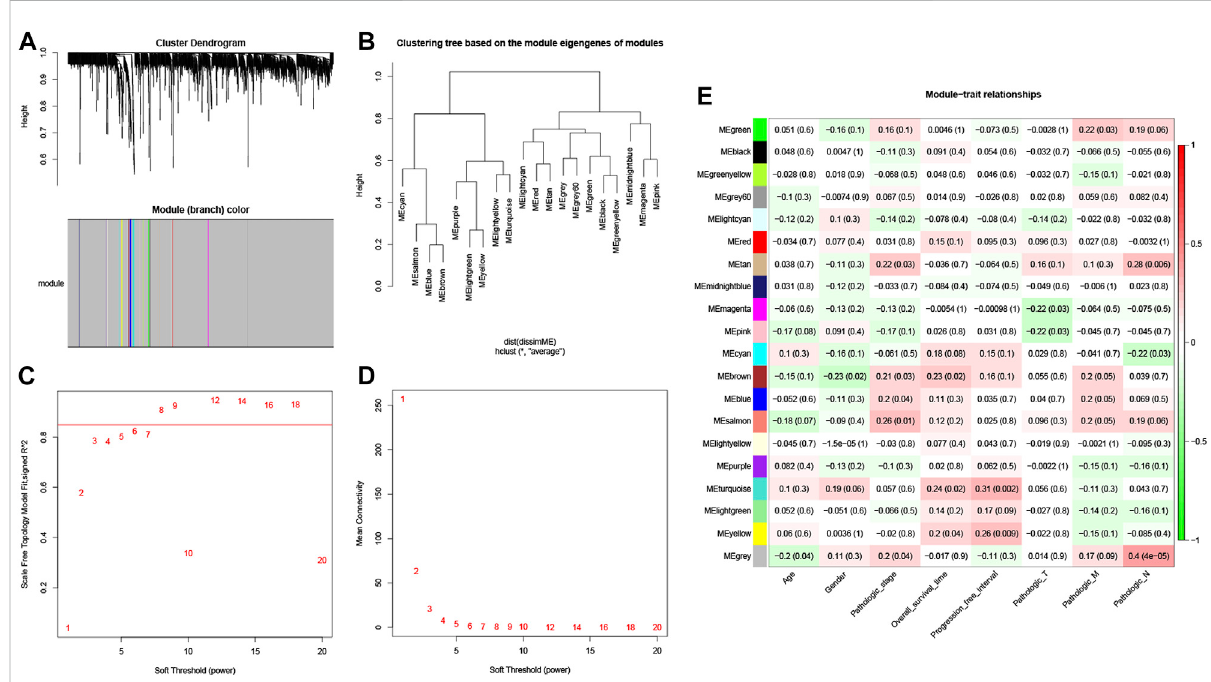
FIGURE 1 Weighted co-expression network analysis. (A) Hierarchical clustering dendrograms of identi fi ed co-expressed m6A-related lncRNAs in modules of CRC. (B) cluster analysis of samples dendrogram. Analysis of the scale-free fi t index (C) and the mean connectivity (D) for various soft- thresholdingpowers. (E) Heatmapsofthemodule-traitassociations wereevaluated bythecorrelation and p valuebetween module eigengenes and sample